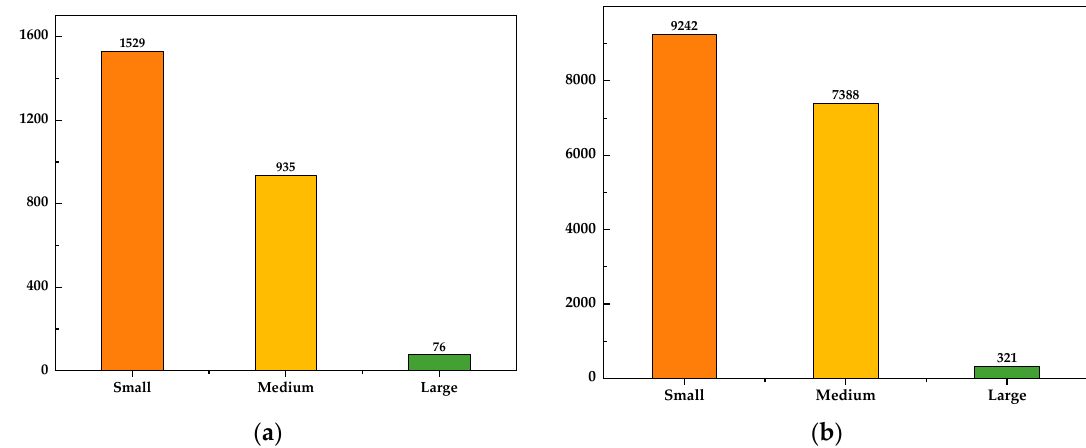
Figure 7. Statistics of the number of ship sizes in two datasets, ( a ) statistics of SSDD, ( b ) statistics of HRSID.